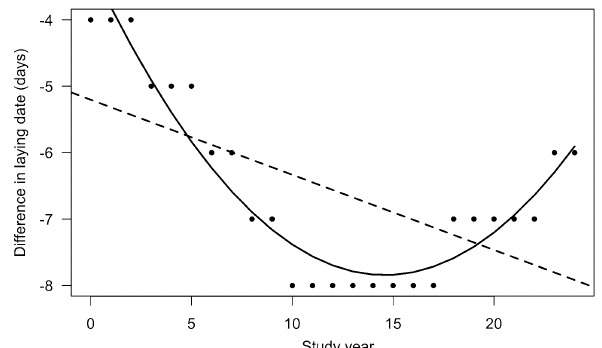
Figure 3. Difference between the laying date yielding the maximal reproductive success and annual median laying date of the greater snow goose population (Difference in laying date) from 1991 to 2015. Black dotted line shows the original linear model and black solid line the a posteriori quadratic model.